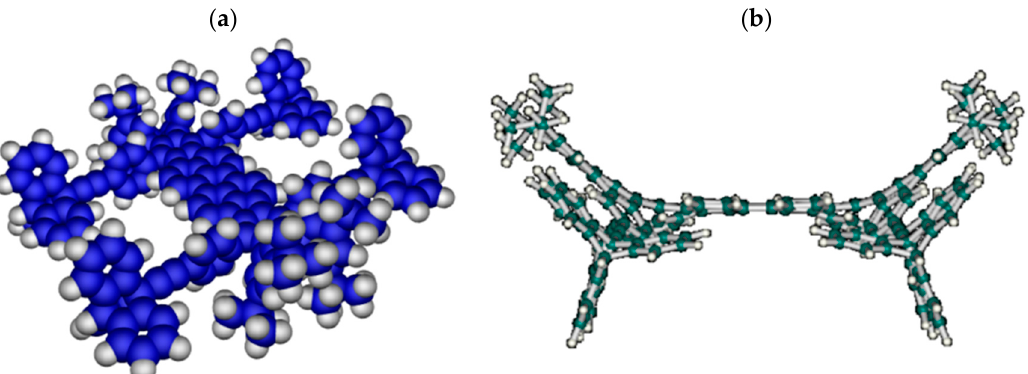
Figure 5. ( a ) CPK (Corey–Pauling–Koltun) model of the nanocar 14 with a planar chassis and ( b ) side view of the optimized geometry of the nanocar 17 with its highly-curved chassis.